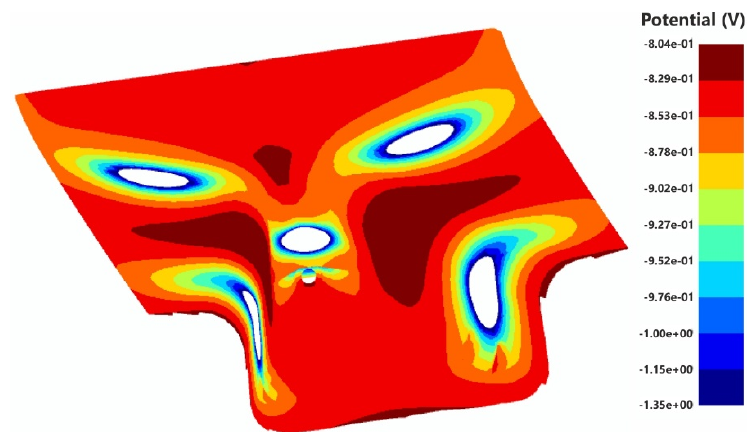
Figure 10. Potential distribution φ (V vs Ag/AgCl/seawater) at the stern area of steel hull.